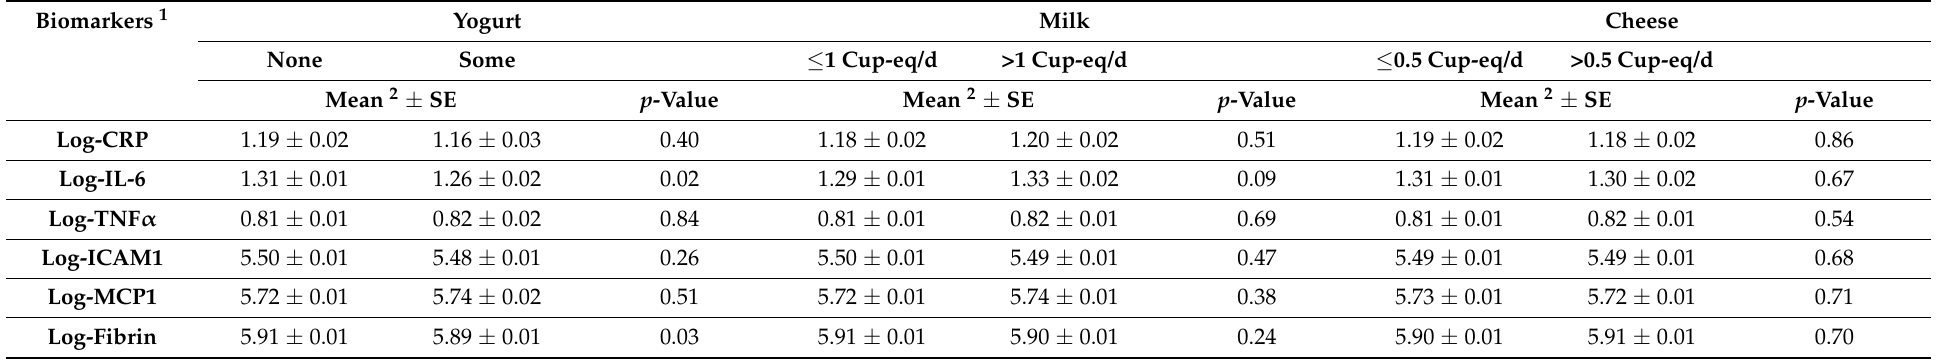
Table 2. Adjusted mean levels of inflammation biomarkers according to dairy food intake